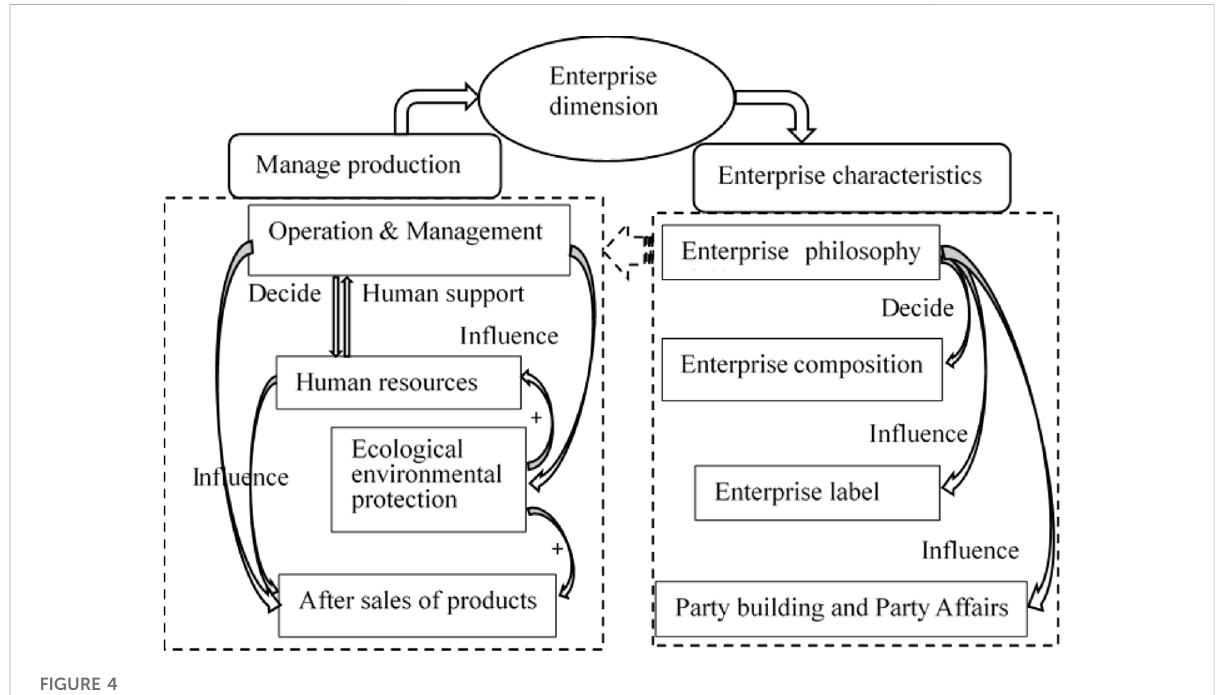
FIGURE 4 Enterprise